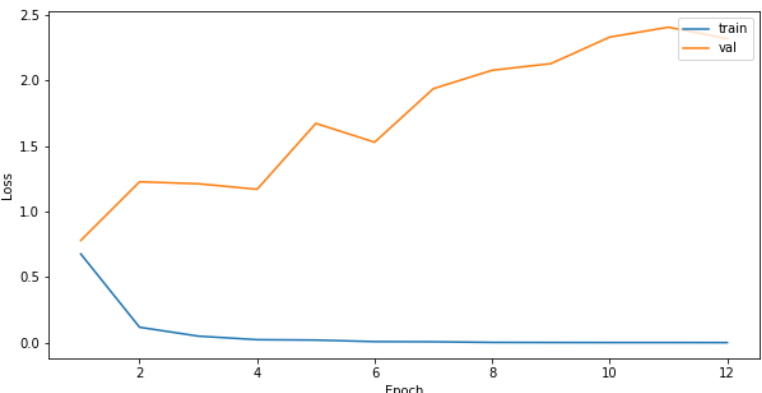
Figure 10. Model loss for the model with 1 layer and a batch size of 256 in relation to different number of epochs used to train the CNN.